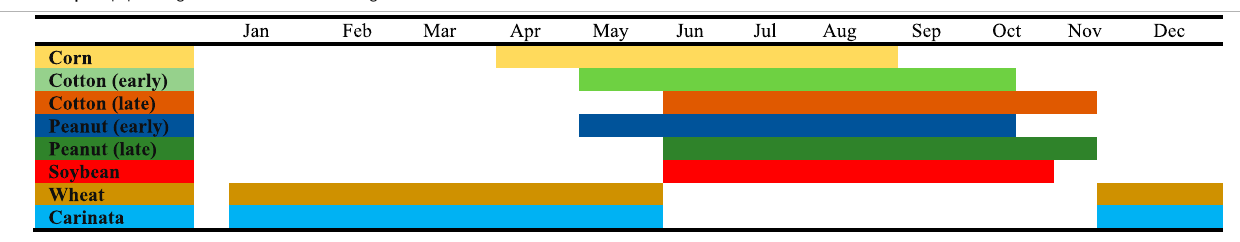
TABLE 1 | Crop planting windows in South